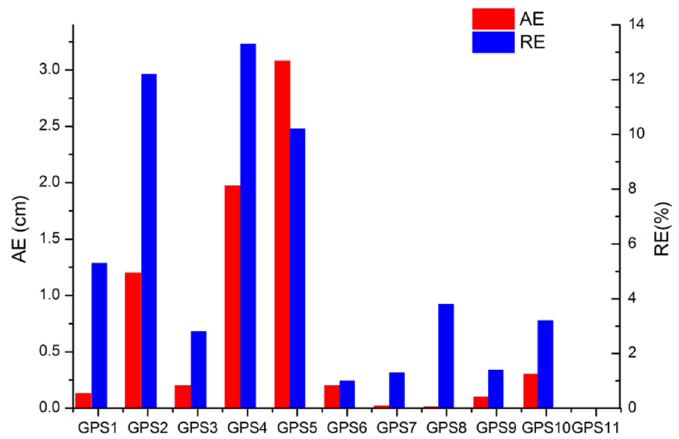
Table 3. Evaluation of the prediction method and results.